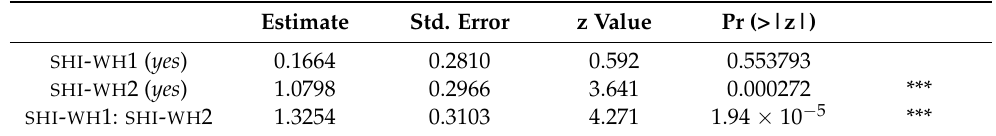
Table 4. Cumulative link mixed model fitted with the Laplace approximation. (Sub-experiment 1 | Nominal-bare.) Estimate Std. Error z Value